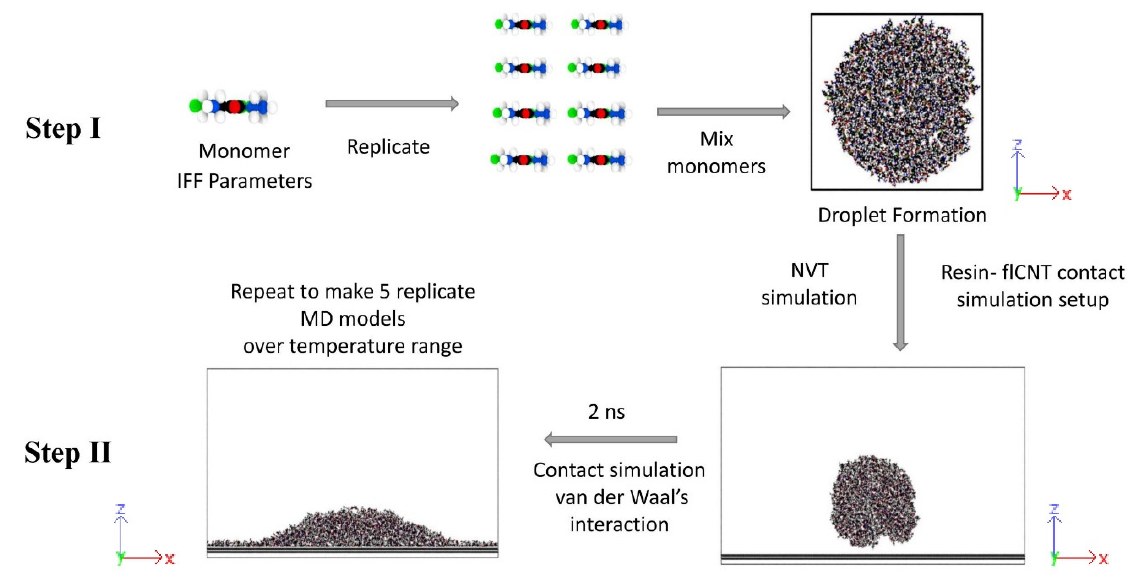
Figure 11. MD workflow for wetting simulations.